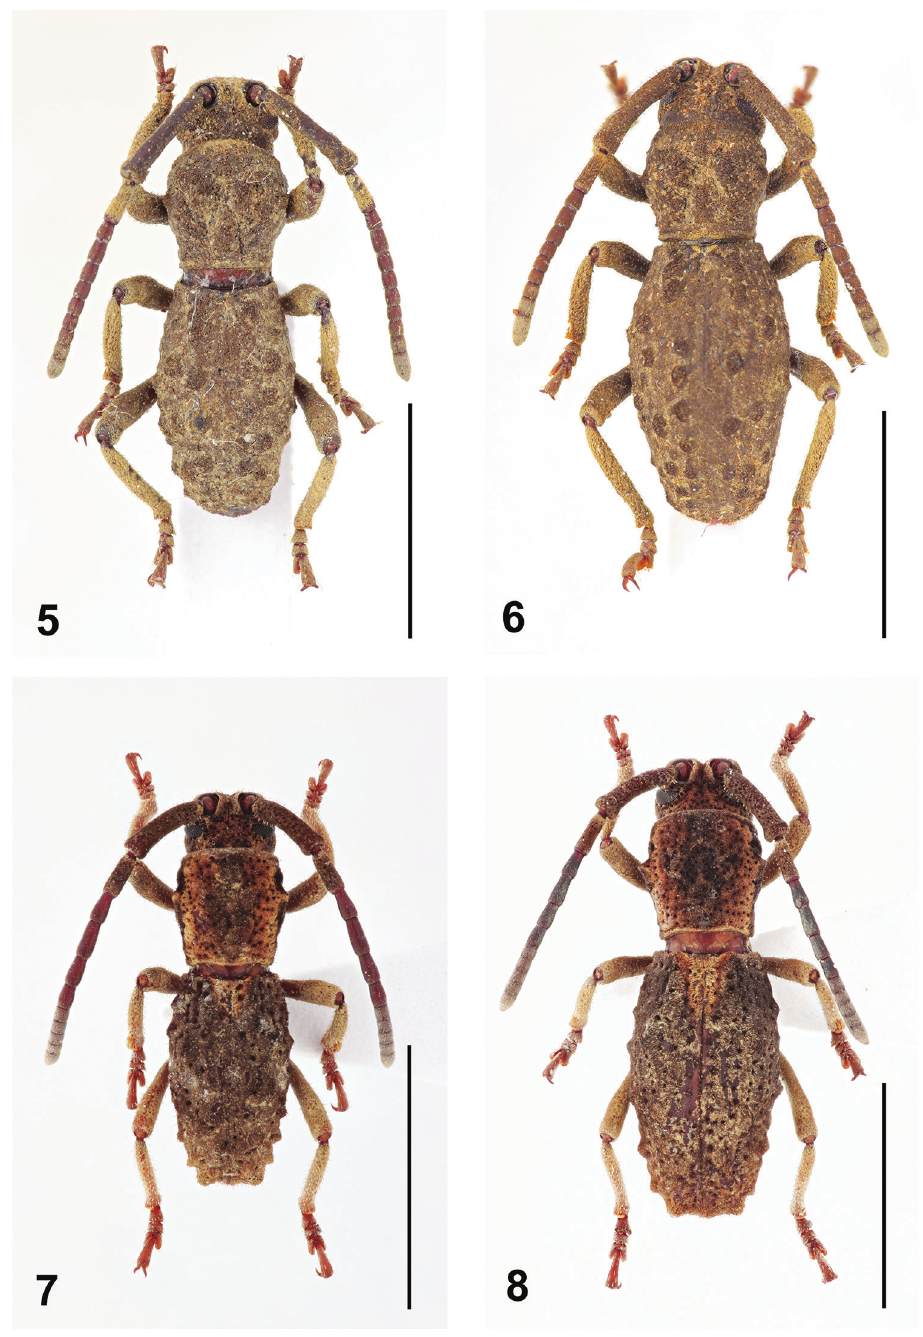
Figures 5–8. Dorsal habitus of Anexodus spp.: 5 Anexodus sarawakensis Sudre, holotype male 6 Anexodus sarawakensis Sudre, paratype female 7 Anexodus tufi sp. n., holotype male 8 Anexodus tufi sp. n., paratype female. Scale bar 5